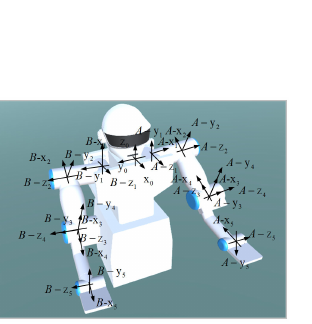
Figure 2. The overall structure of the